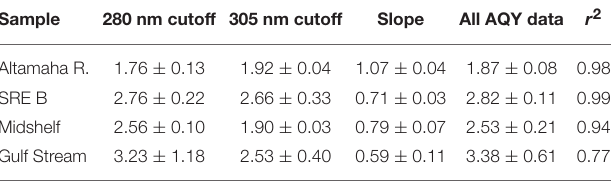
TABLE 2 | O − 2 :H 2 O 2 ratios measured directly (under either the 280 or 305 nm cutoff filters, n = 2) or from all AQY experimental data and the slope of the regression of H 2 O 2 generated without SOD vs. that with SOD (Ratio = 2 divided by the slope; regressions shown in Figure 4).